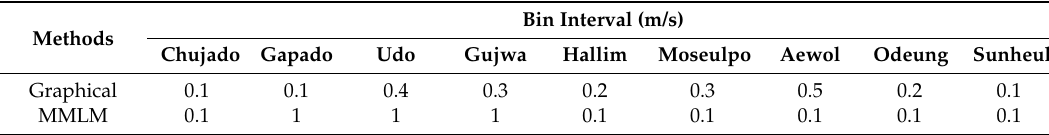
Table 4. The appropriate bin intervals for the